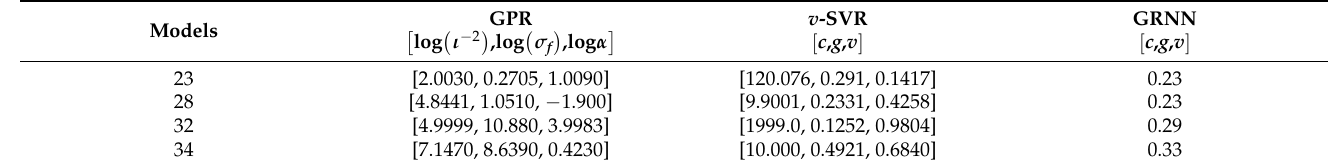
Figure 12. RMSE obtained from WOA-GPR with different samples and cycles for Case 2. Table 8. The parameters of different algorithms for Dangchuan Landslide.